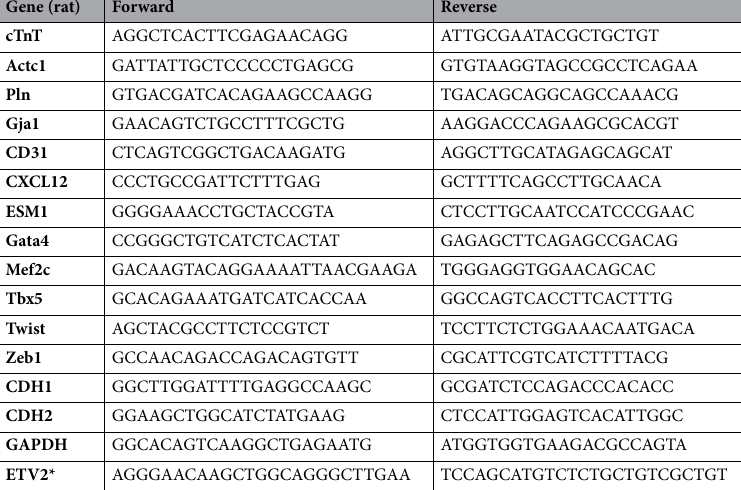
Table 1. Primer sequences used for quantitative reverse transcriptase polymerase chain reaction.